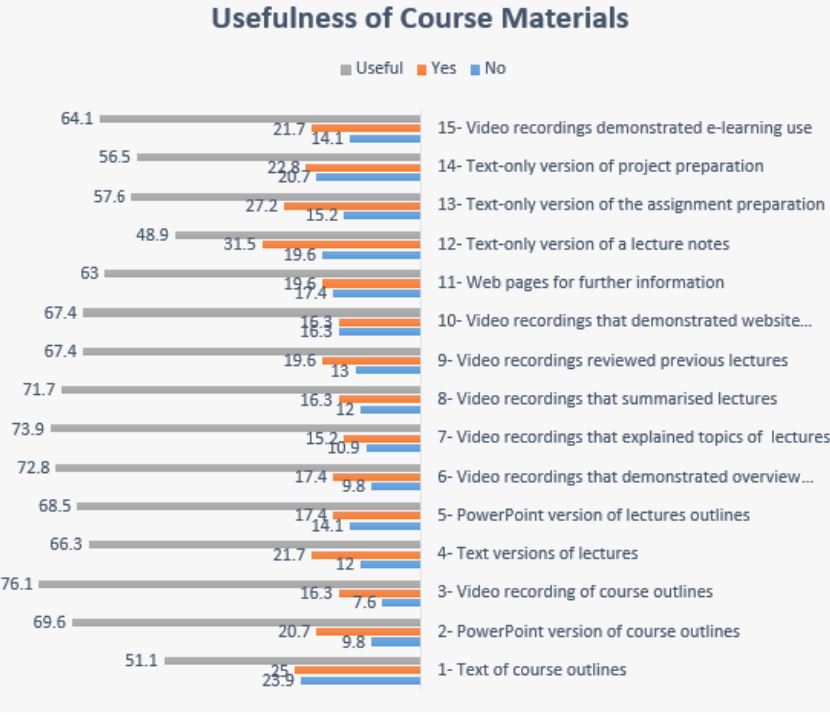
Figure 9. The usefulness of the course materials (%).